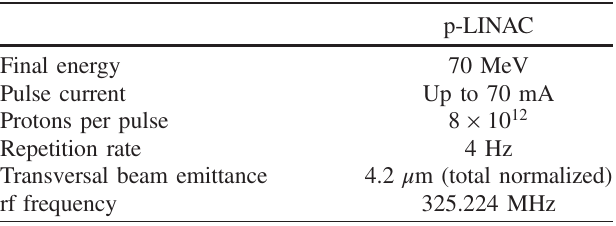
TABLE I. Main parameters of the FAIR proton linac.